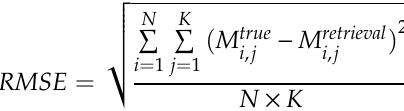
Table 1. System specifications employed by Monte-Carlo (MC) simulations.